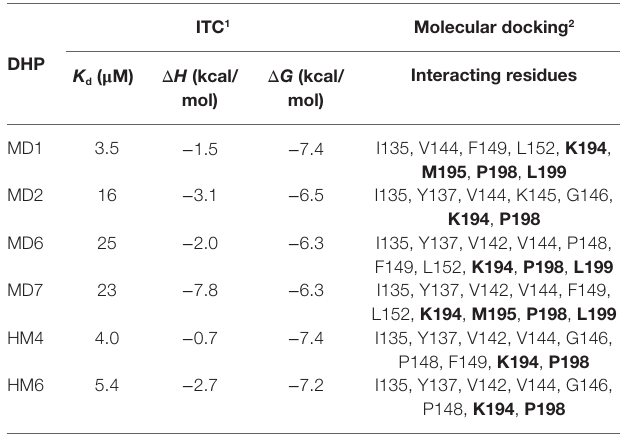
TABLE 3 | Thermodynamic parameters and interacting amino acid residues of the protein-ligand complexes formed between HsrA and selected DHP-based HHQ derivatives, according to ITC and molecular docking analyses.